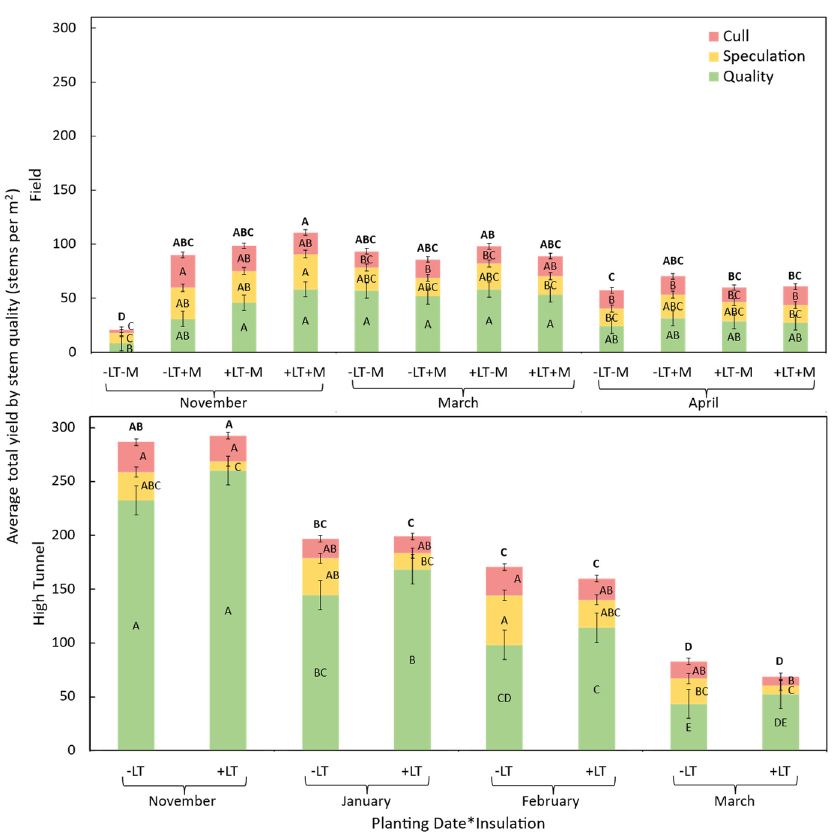
Figure 5. The average ranunculus yield in stems per m 2 by planting date and insulation in a North Logan, UT field ( top ) and high tunnel ( bottom ) across 2020–21 and 2021–22. In the field, plants were covered with no insulation (-LT-M), mulch (-LT+M), a low tunnel (+LT-M), or a low tunnel and mulch (+LT+M). In the high tunnel, plants were covered with no insulation (-LT) or a low tunnel (+LT). Stems were graded as quality (greater than 25 cm stem length), speculation (20–25 cm), or cull (<20 cm). Mean total yields marked by bolded different letters at the top of a bar and means marked by different letters within a length category are significantly different according to Tukey’s HSD test at α = 0.05.